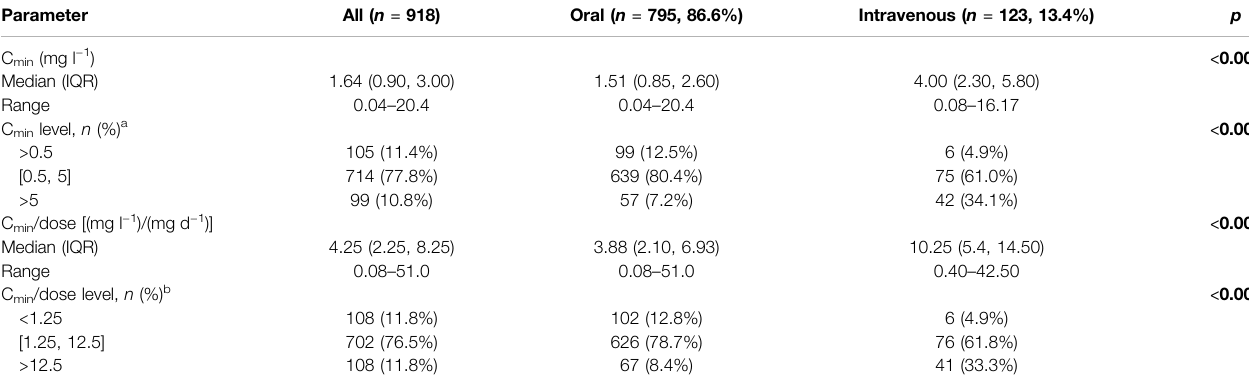
TABLE 2 | VRC plasma trough concentration included in the